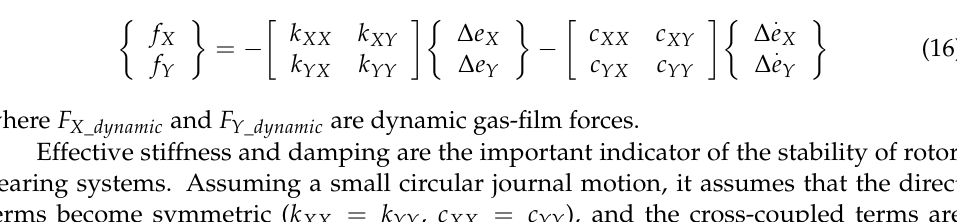
Figure 11. Dynamic direct and cross-coupled properties of the GFPB acting on the journal.